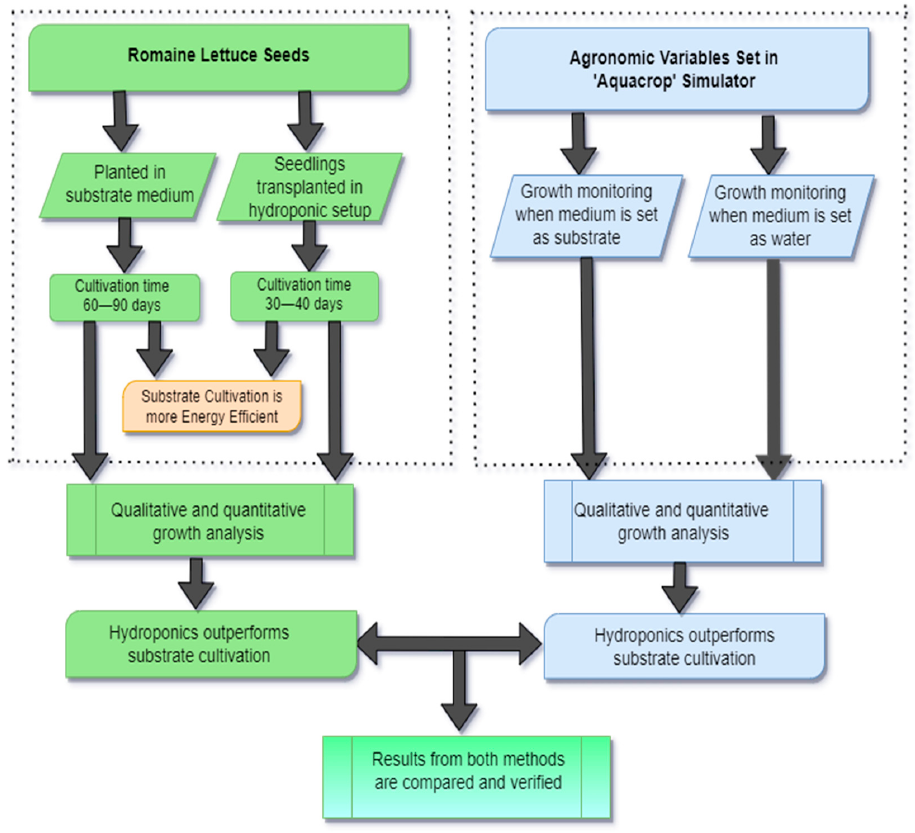
Figure 6. Workflow of the proposed research work.